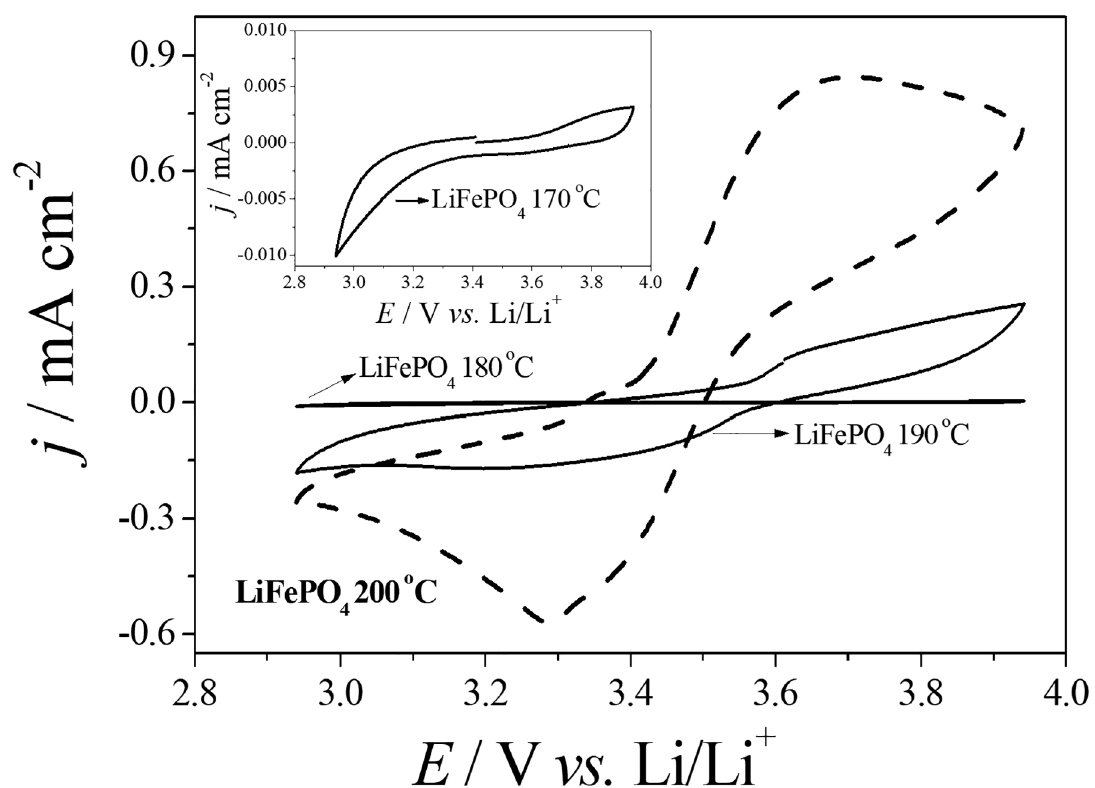
in EC:DMC 1:1 ( V / V ), of LiFePO synthesized at 170 ºC, 4 4